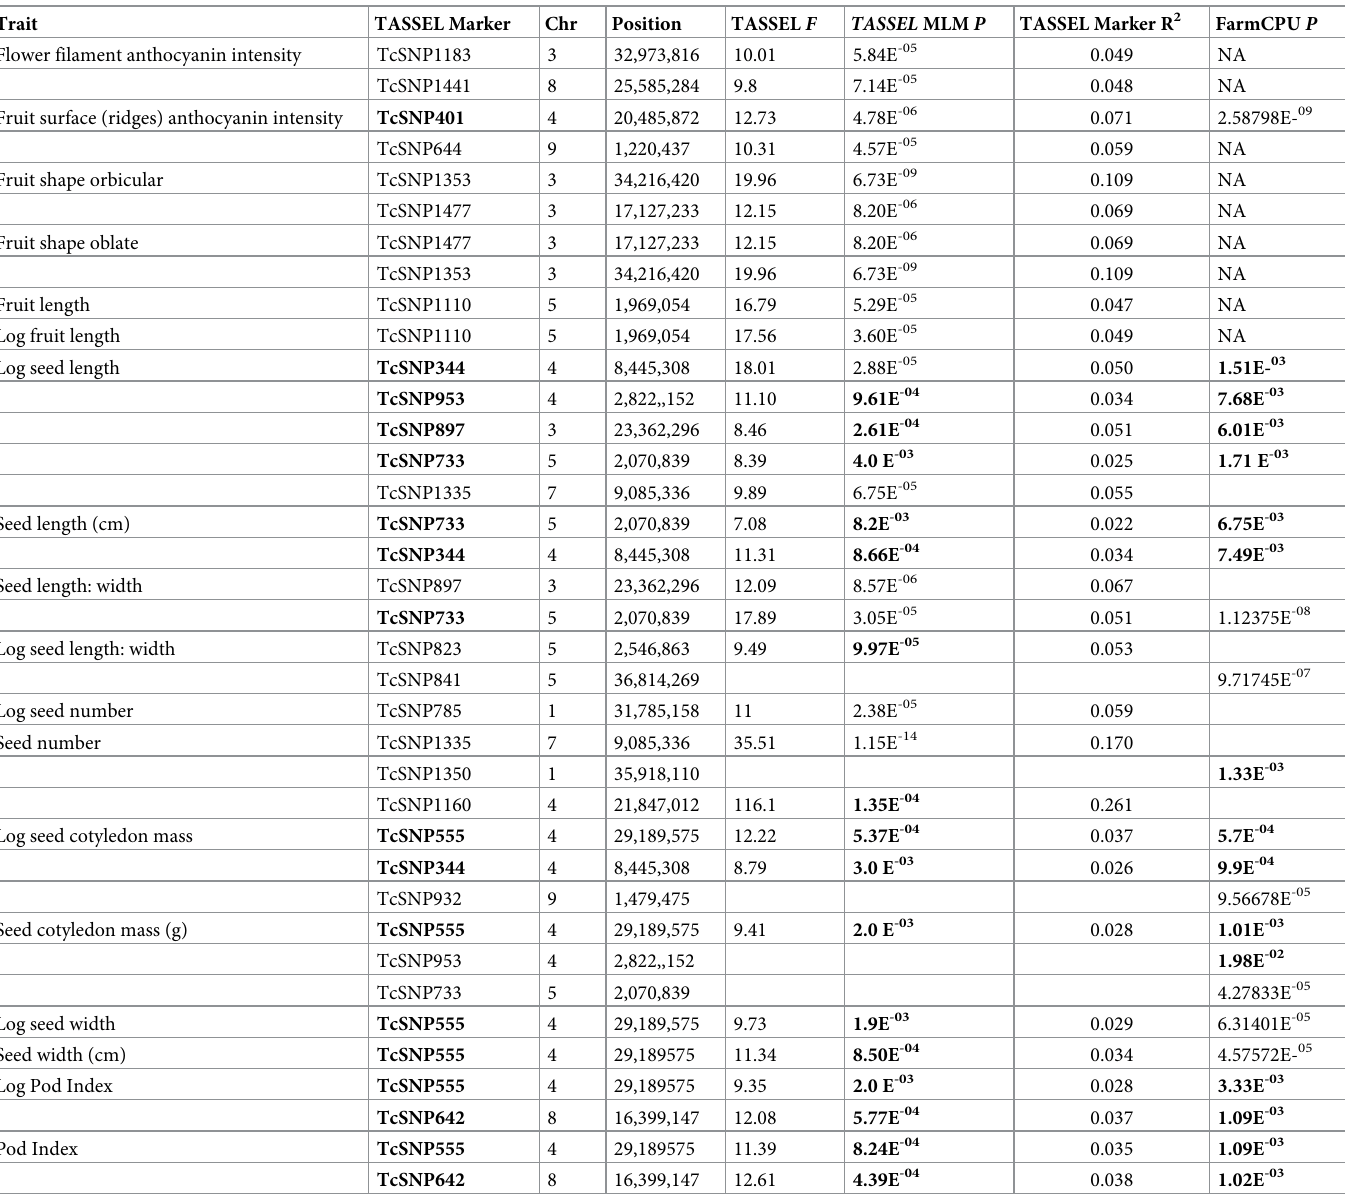
Table 3. Most significant, yield-related and other marker-trait associations and variation explained.